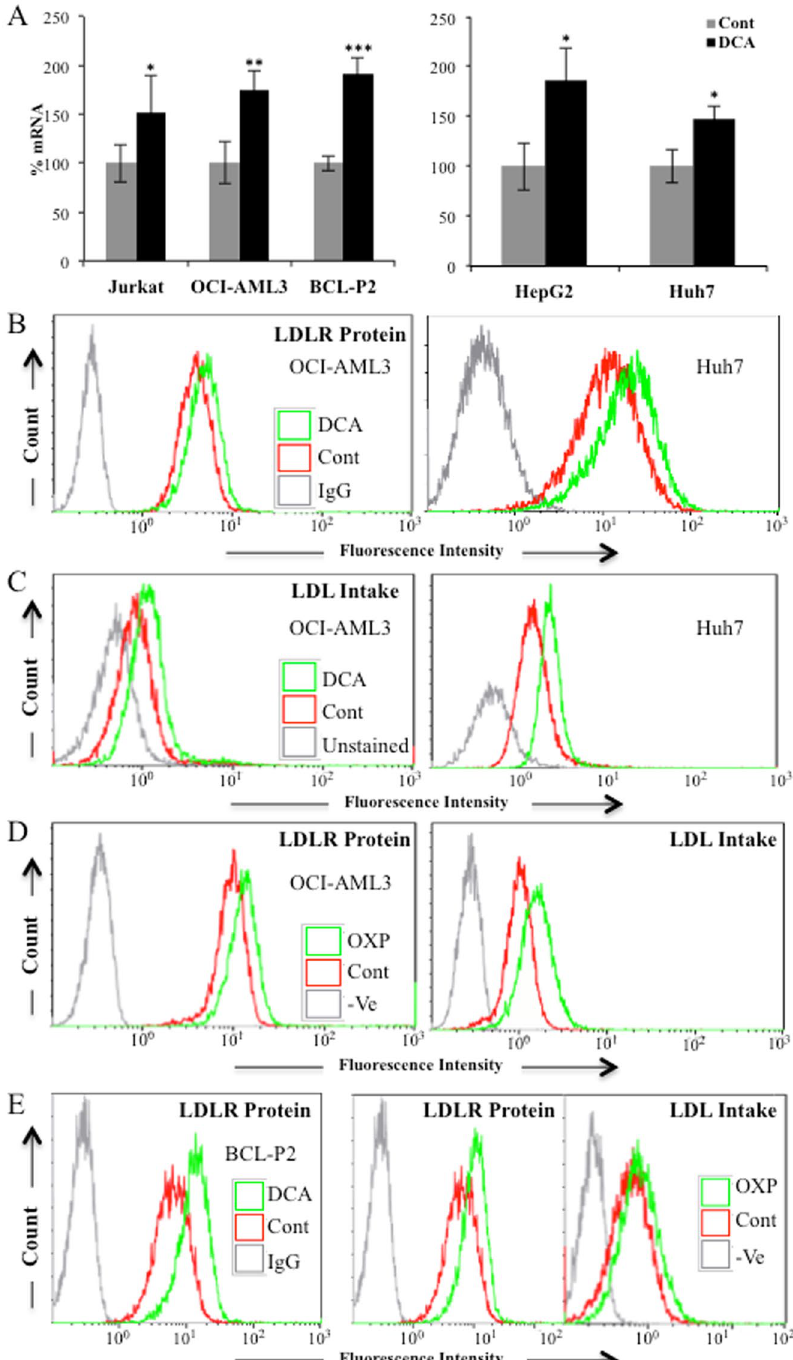
Figure 1. OXPHOS induced LDLR expression and LDL uptake. ( A ) The hematopoietic cell lines Jurkat and OCI-AML3 and primary cells from a BCL patient (BCL-P2) as well as HepG2-C3A and Huh7 hepatic cell lines were treated with 10 mM DCA for 24 h and LDLR mRNA was analyzed by RT-qPCR. ( B ) Cell lines were treated for 72 h with 5 mM DCA and LDLR protein in plasma membrane was analyzed by FACs. ( C ) Cells were treated as in ( B ) and fluorescent LDL intake analyzed by FACs. ( D ) OCI-AML3 cells were grown in OXPHOS medium for 2 weeks and LDLR expression (left) and LDL intake (right) were analyzed by FACs. ( E ) BCL-P2 cells were treated with 5 mM DCA for 1 week (left) or were grown in OXPHOS medium for 2 weeks (center) and LDLR protein in plasma membrane analyzed by FACs. LDL intake (right) was analyzed in cells growing in OXPHOS. The bar graphs represent means ± SD of 3 independent experiments performed in triplicate; * p < 0.05, ** p < 0.01, *** p < 0.005 student t-test compared to control